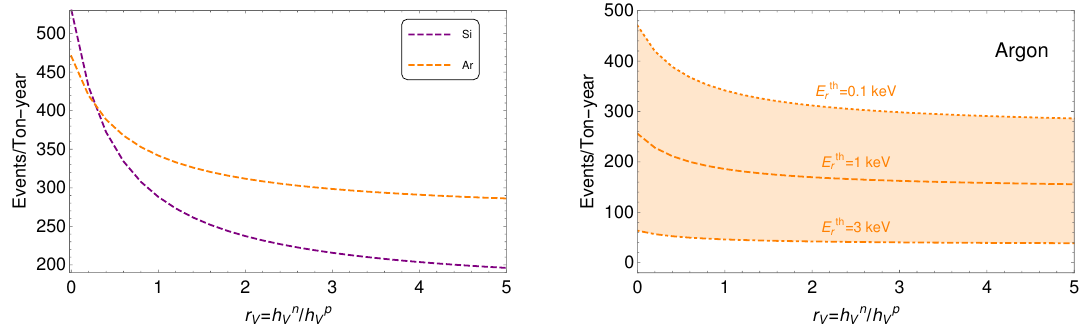
Figure 5 . Left graph : expected number of events in silicon and argon detectors as a function of r V = h n =h p ( h n and h p refer to the couplings of the new \heavy" vector to neutrons V V V V